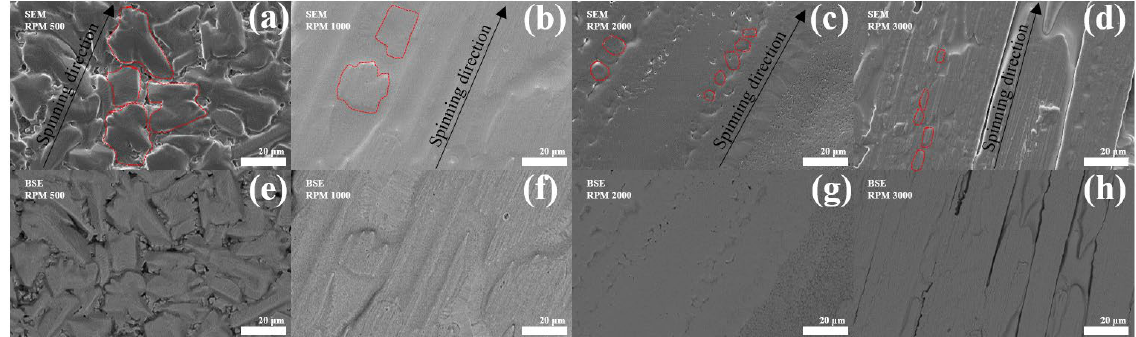
Figure 4. SEM and BSE images of the Sm(Fe 0 . 8 Co 0 . 2 ) 10 Si 2 ribbons with the wheel speeds of ( a , e ) 6.5, ( b , f ) 13, ( c , g ) 26, and ( d , h ) 39 m/s, respectively.